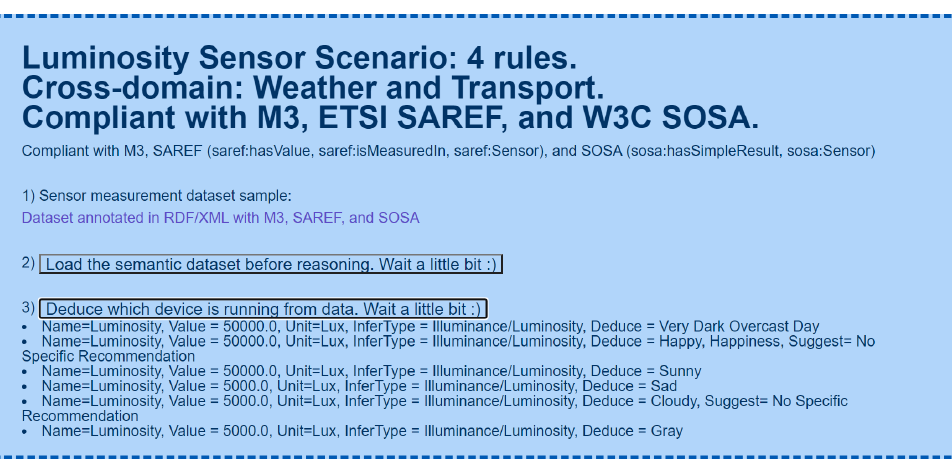
Figure A14. Luminosity and Emotion